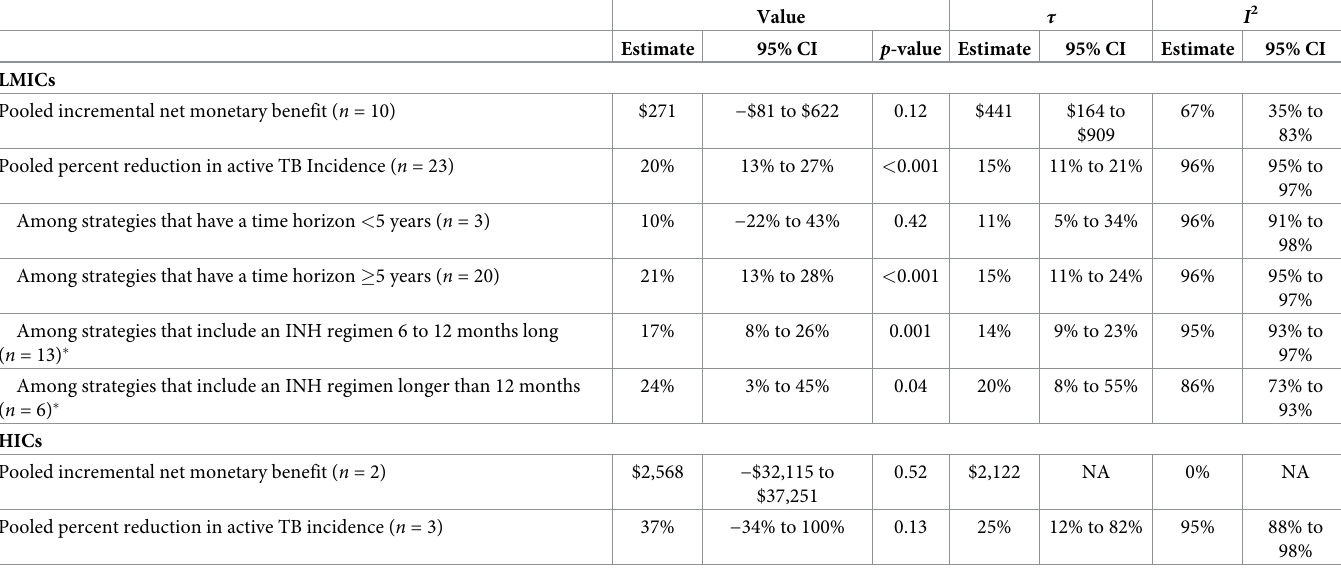
Table 6. Pooled incremental net monetary benefit (2020 USD) and percent reduction in active TB incidence comparing TPT to no